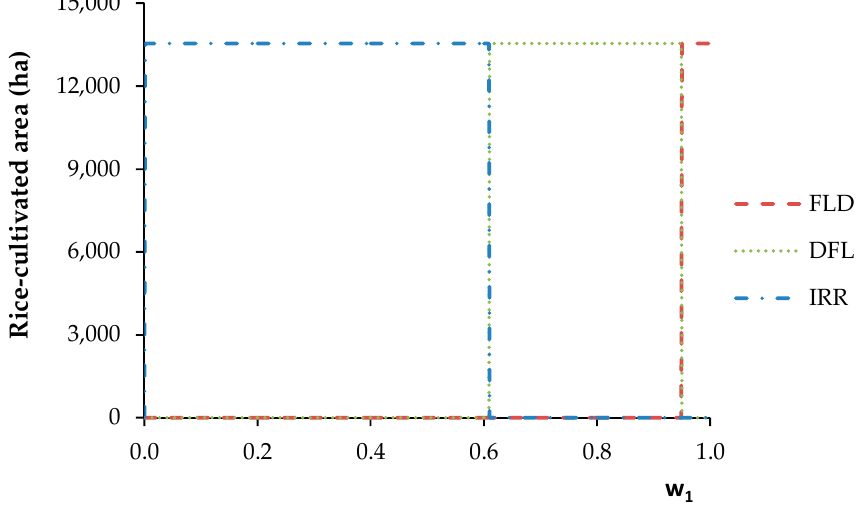
Figure 4. Rice ‐ cultivated area under different irrigation practices. Figure 4. Rice-cultivated area under different irrigation